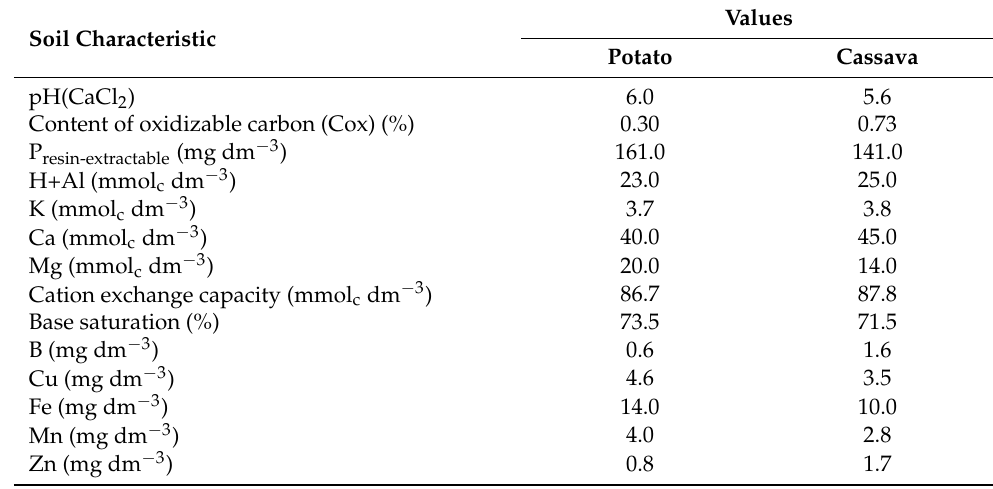
Table 1. Soil chemical characteristics at the soils after correction and fertilization. Soil Characteristic